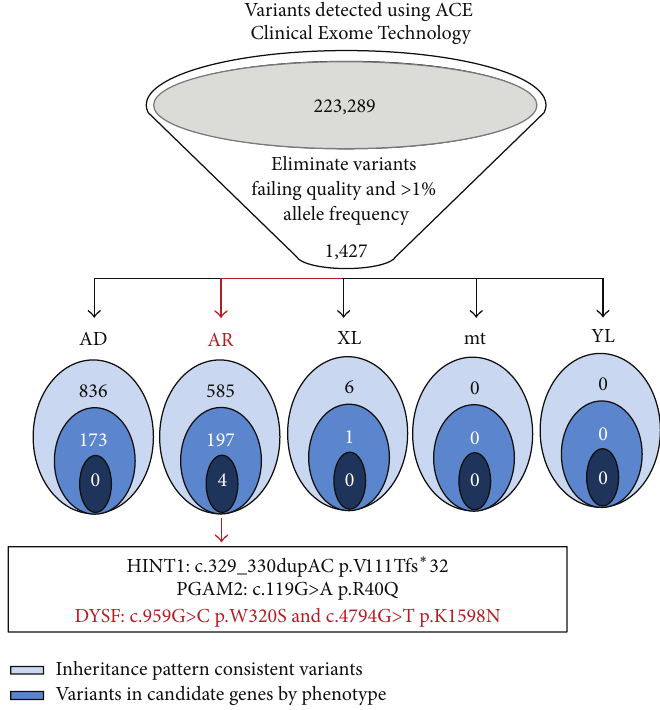
Figure 2: Whole Exome Sequencing analysis. Whole Exome Sequencing was completed at Personalis and variants were detected using their ACE Clinical Exome Pipeline. Variants were filtered by Personalis as described above, first with the elimination of variants with poor quality and > 1%frequency.Then,variantsweresortedbasedoninheritancepattern(AD:autosomaldominant,AR:autosomalrecessive,XL:X-linked, mt: mitochondria, and YL: Y-linked) and variants were kept if the gene matched the phenotype. The variants that were the best matches after manual review were reported. Four variants in three genes (HINT1, PGAM2, and DYSF) passed all filtering steps. Two variants were detected in DYSF and information regarding the variants is described in Table